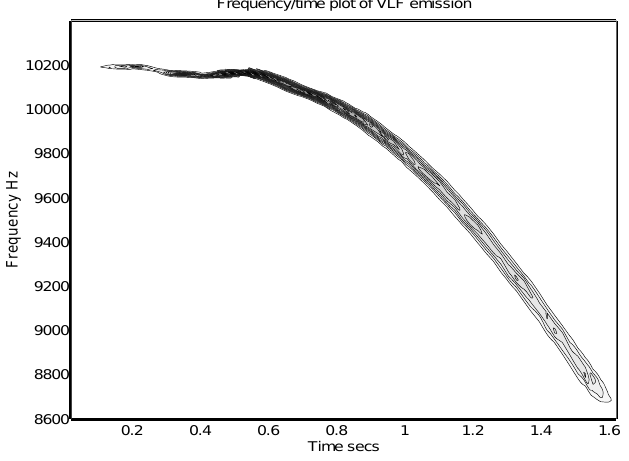
Fig. 13. Run 2. Omega triggered faller.